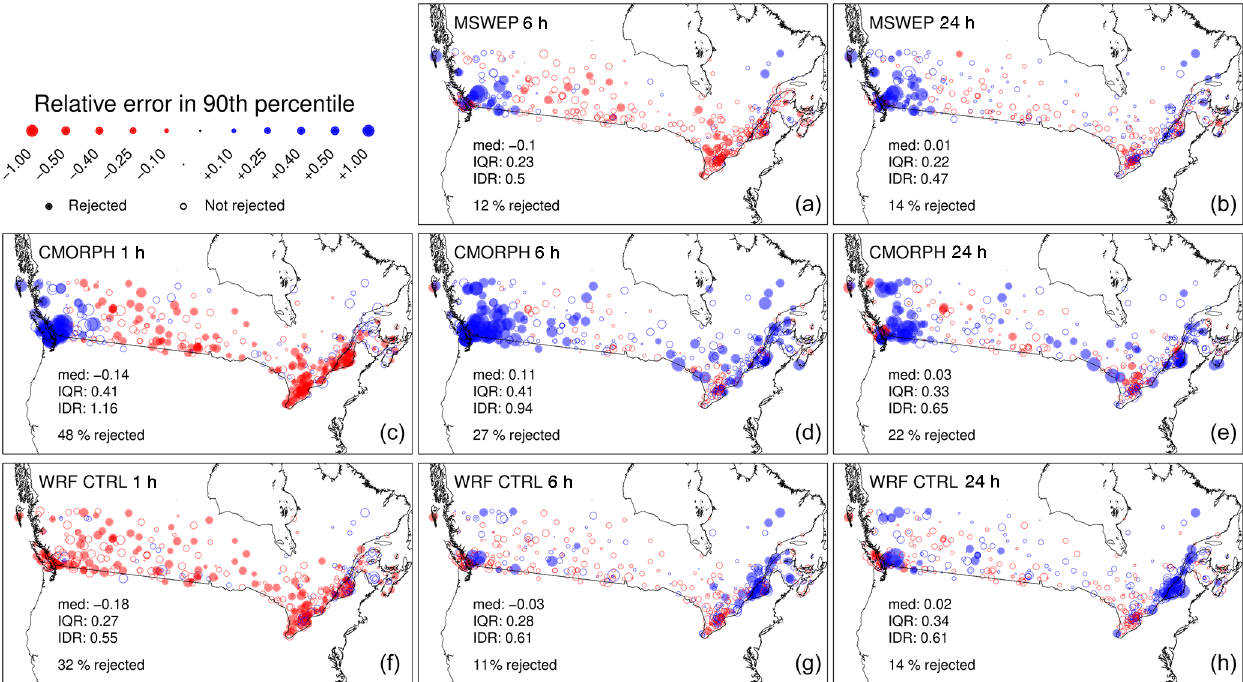
Figure 4. Relative error (RE) in the empirical 90th percentile (10-year return level) of annual maximum rainfall intensities between each MSWEP (a, b) , CMORPH (c, d, e) , and WRF CTRL (f, g, h) gridded dataset and station observation for 1h (c, f) , 6h (a, d, g) , and 24h (b, e, h) accumulation durations. Summary statistics reported in each figure include the median (med), interquartile range (IQR), and interdecile range (IDR) of RE, as well as the percentage of locations exhibiting statistically significant values of RE. Statistical testing is performed at the 0.05 significance